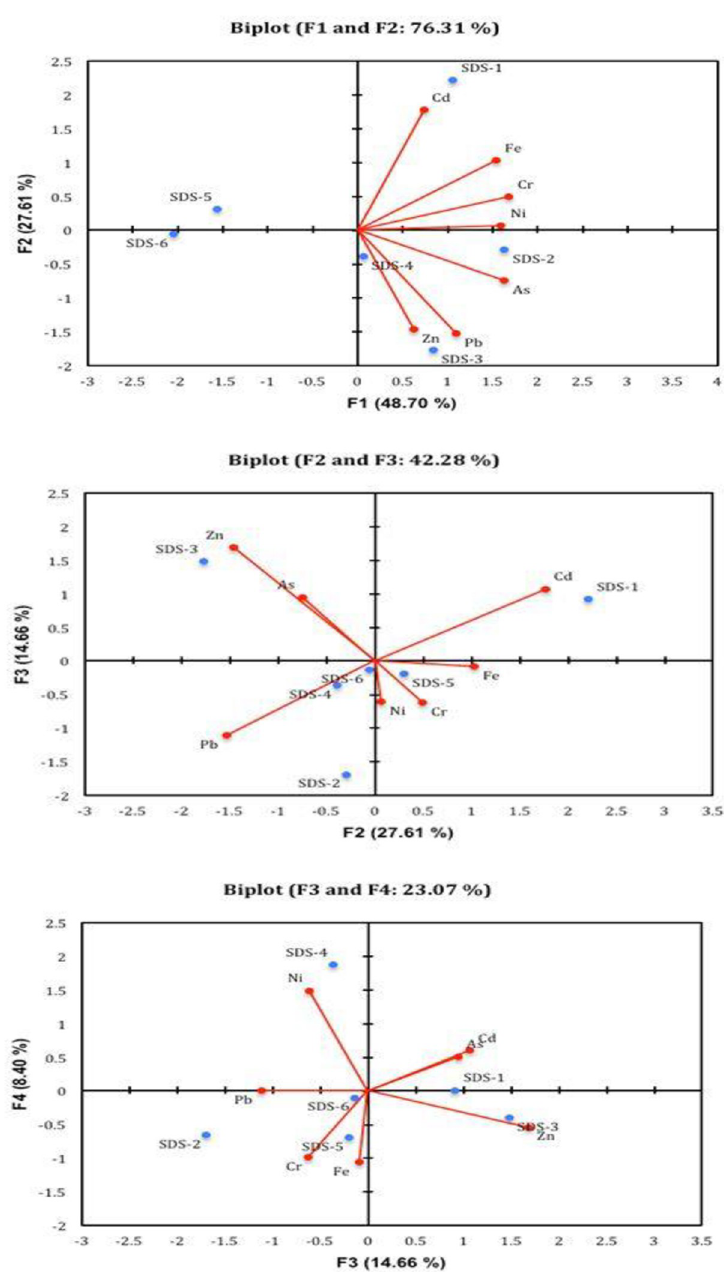
Fig 3. The two principal components reflecting the relationship of study sites and heavy metals (variables) in sediment